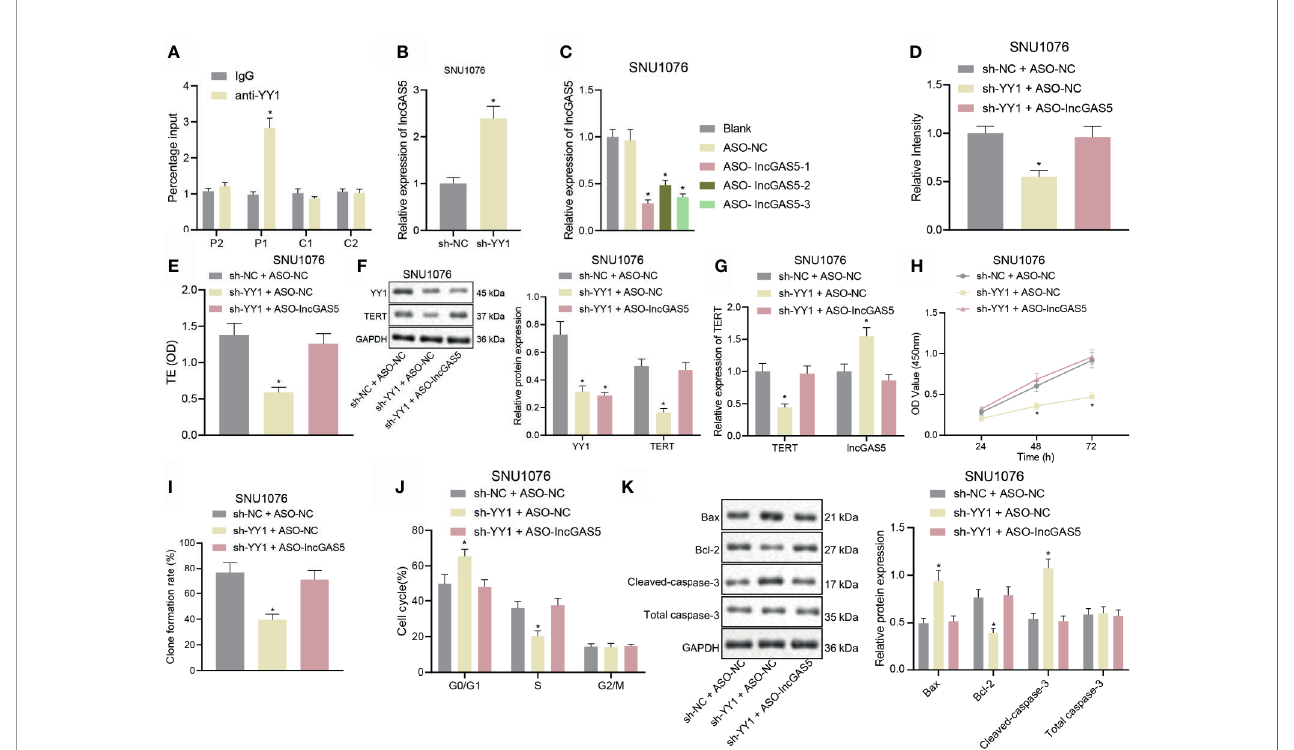
FIGURE 3 | YY1 boosts telomerase activity and proliferation but inhibits apoptosis of LSCC SNU1076 cells by suppressing GAS5. (A) ChIP-qPCR was used to detect the binding of YY1 to GAS5 promoter. Primers were designed for P1 and P2 upstream of YY1 and C1 and C2 downstream of YY1. qPCR detected ChIP enriched DNA, * indicates p < 0.05 compared with sh-NC + ASO-NC. (B) GAS5 expression determined by RT-qPCR in SNU1076 cells transfected with sh-YY1, * indicates p < 0.05 compared with sh-NC. (C) Knockdown ef fi ciency of GAS5 con fi rmed by RT-qPCR in SNU1076 cells, * indicates p < 0.05 compared with ASO- NC. (D) Telomerase length in cells detected by PCR-ELISA. (E) Telomerase activity in cells. (F) Western blot analysis of YY1 and TERT proteins in SNU1076 cells, normalized to GAPDH. (G) mRNA expression of TERT and GAS5 in SNU1076 cells determined by RT-qPCR. (H) SNU1076 cell proliferation measured by CCK-8 assay. (I) Colony formation of SNU1076 cells measured by colony formation assay. (J) SNU1076 cell cycle distribution measured by fl ow cytometry. (K) Western blot analysis of Bax, Bcl-2 and cleaved caspase-3 proteins in SNU1076 cells, normalized to GAPDH, * indicates p < 0.05 compared with sh-NC + ASO-NC. Data are expressed as mean ± standard error of the mean. Data are shown as mean ± standard deviation of three technical replicates. Data between two groups were compared by unpaired t -test while those among multiple groups were compared by one-way ANOVA with Tukey ’ s post-hoc tests. Bonferroni-corrected two-way ANOVA was applied for data comparison at various time